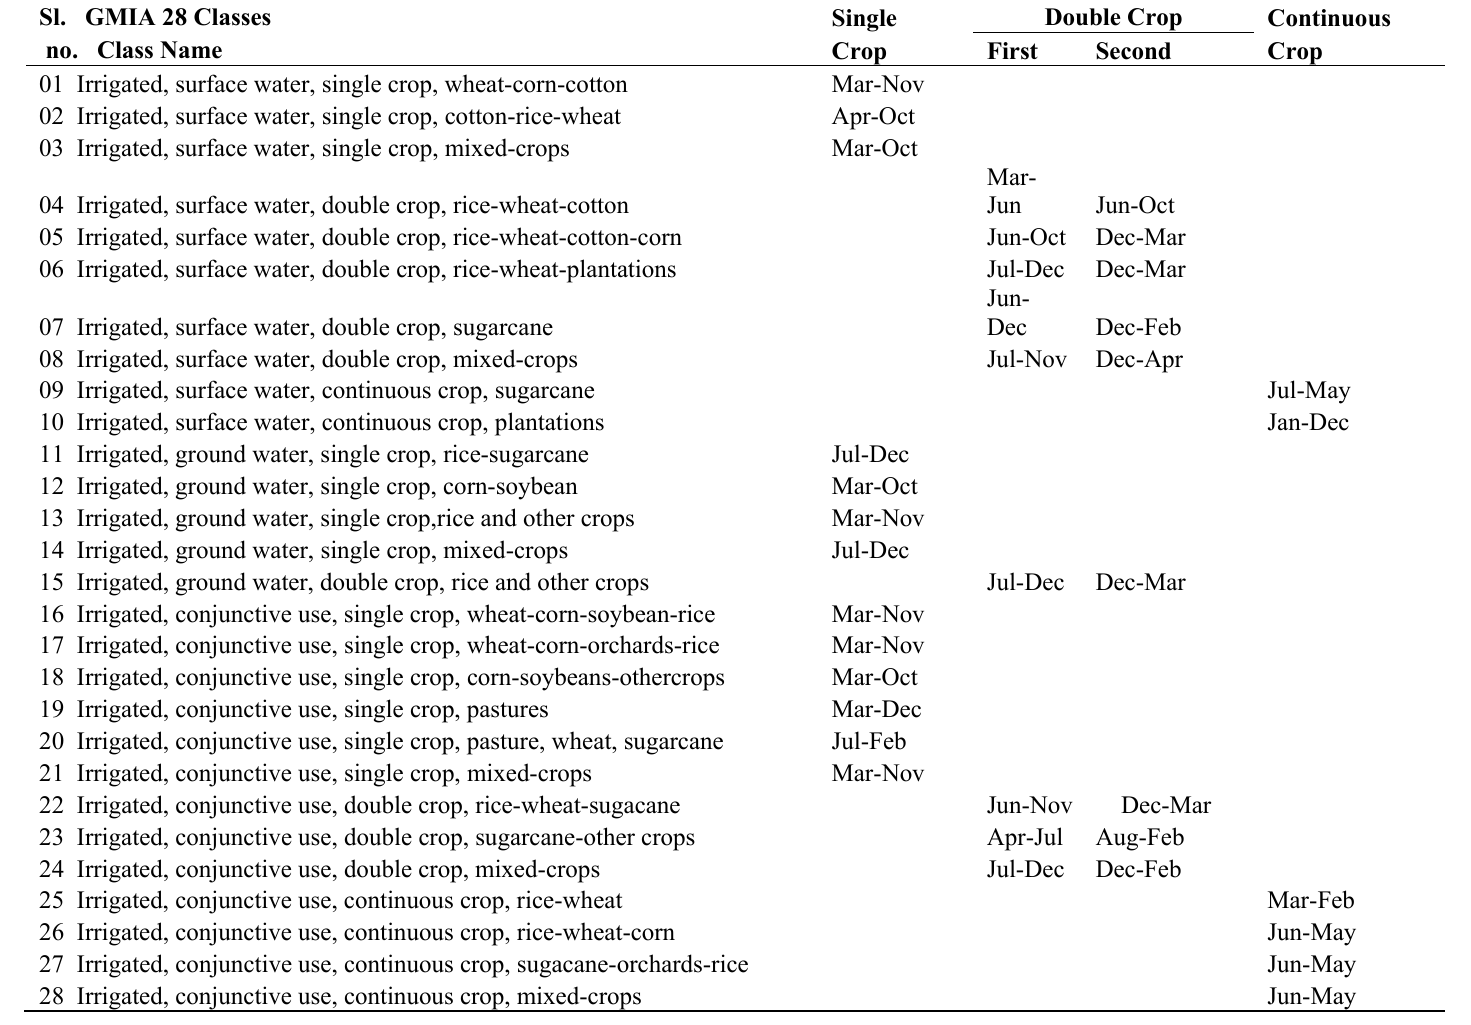
Table 2. Cropping calendar to compute areas based on intensity or seasonality of